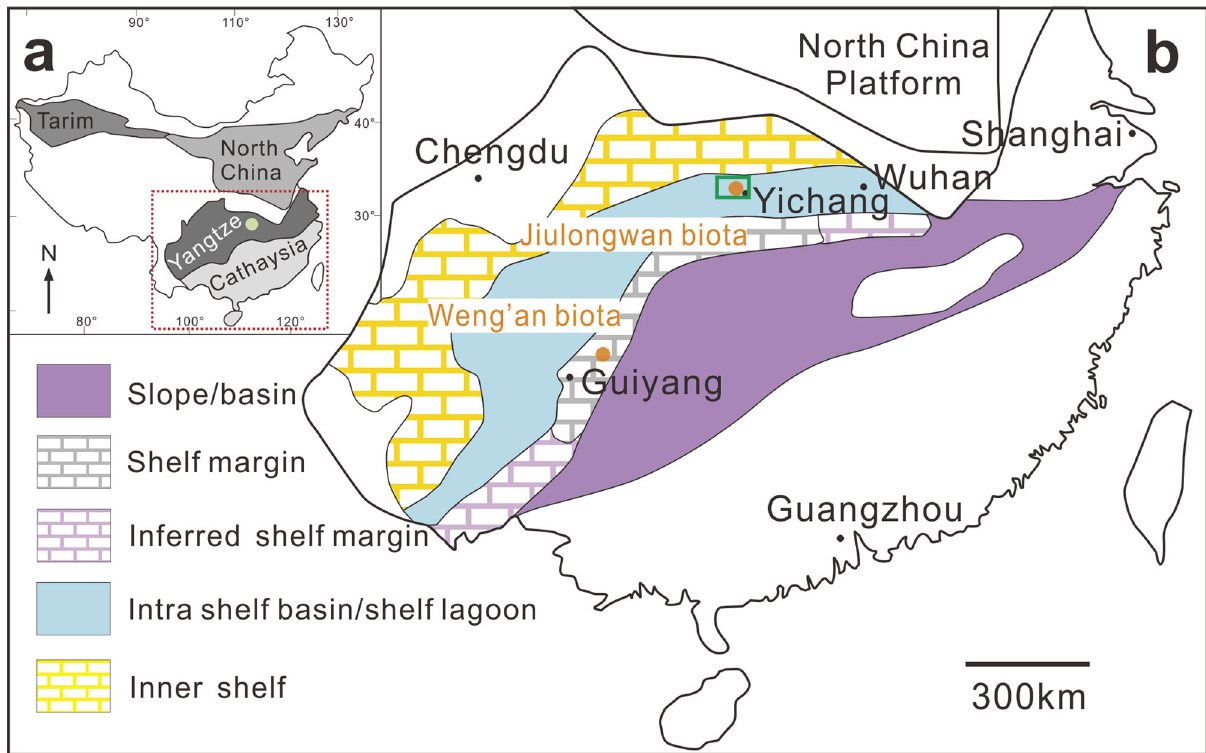
Fig. 1 Geological map of the Yangtze Gorges Area. a Location of the Yangtze Block ( b ) Location and generalized paleogeographic reconstruction of the Yangtze platform during Doushantuo deposition (adapted from ref. 9 ) and locations of the investigated Sixi Section and Qinglinkou Section (green